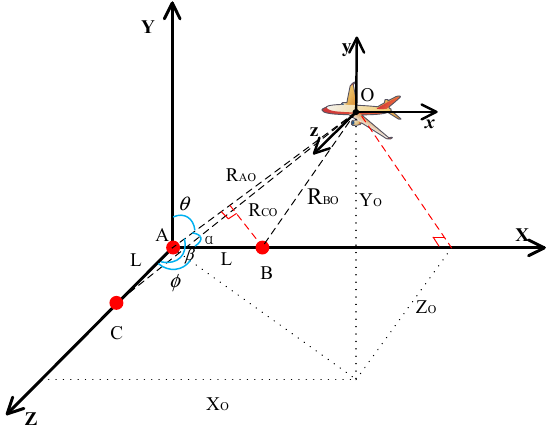
Figure 1. InISAR imaging under squint model.